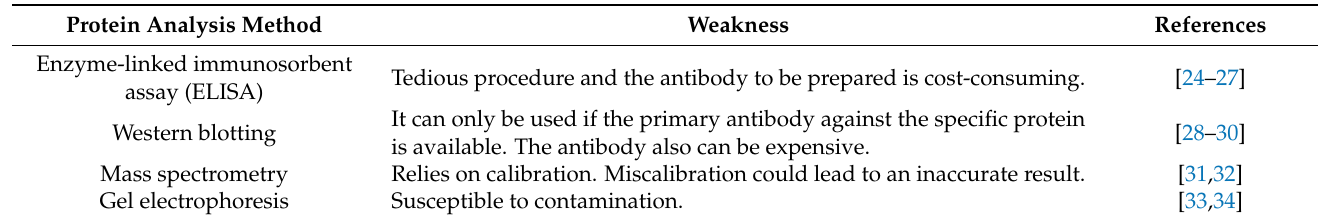
Table 2. Conventional protein analyses and their weaknesses. Protein Analysis Method